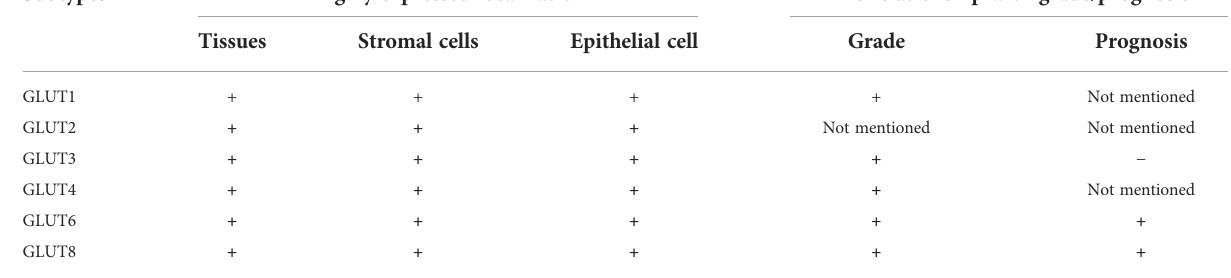
TABLE 1 Expression of glucose transporters in endometrial